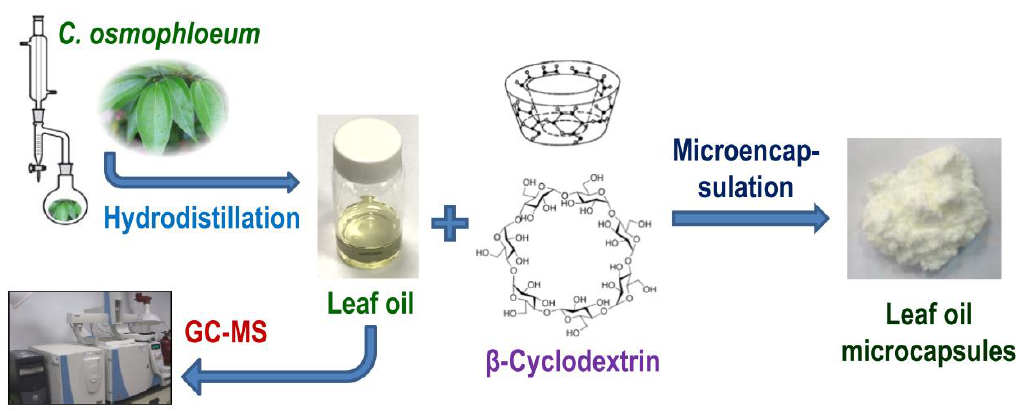
Figure 1. Schematic illustration of microencapsulation of C. osmophloeum leaf oil with β-cyclodextrin.